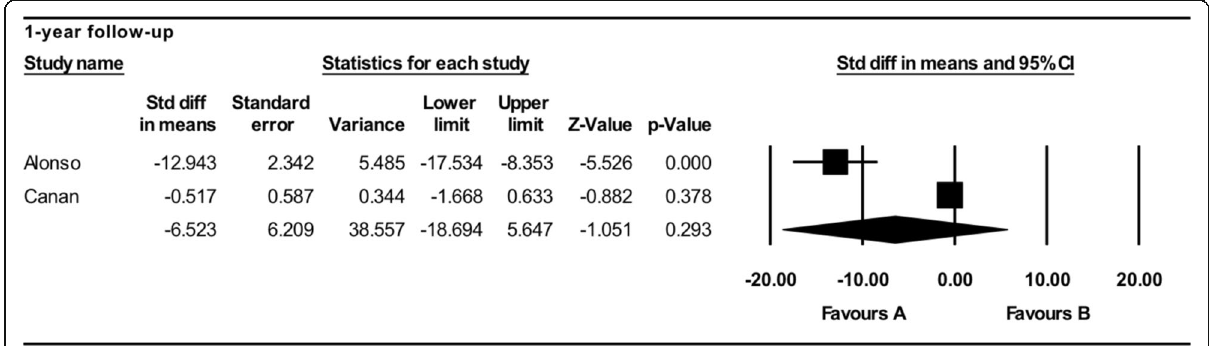
Fig. 6 Subgroup analysis of radiographic assessment between autologous bone and rh-BMP2 graft: bone graft height after a 1-year follow-up considering the patient ’ s age [favors A: autologous bone graft; favors B: alloplastic bone